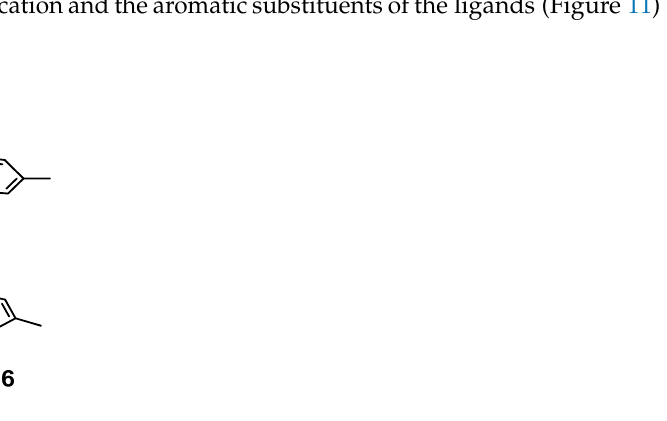
Figure 11. Electronic and steric stabilization of barium by aryl substituents in guanidinato ligands.